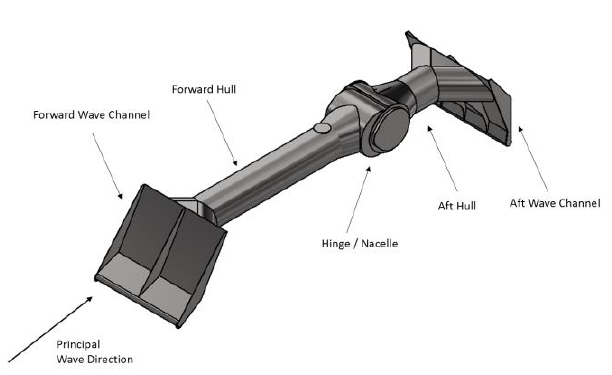
Fig. 1. The Mocean M100 WEC with labels indicating key geometric features. The figure shows the M100a; Mocean is currently developing an iteration beyond this that can be found at www.moceanenergy.com and is referred to as the